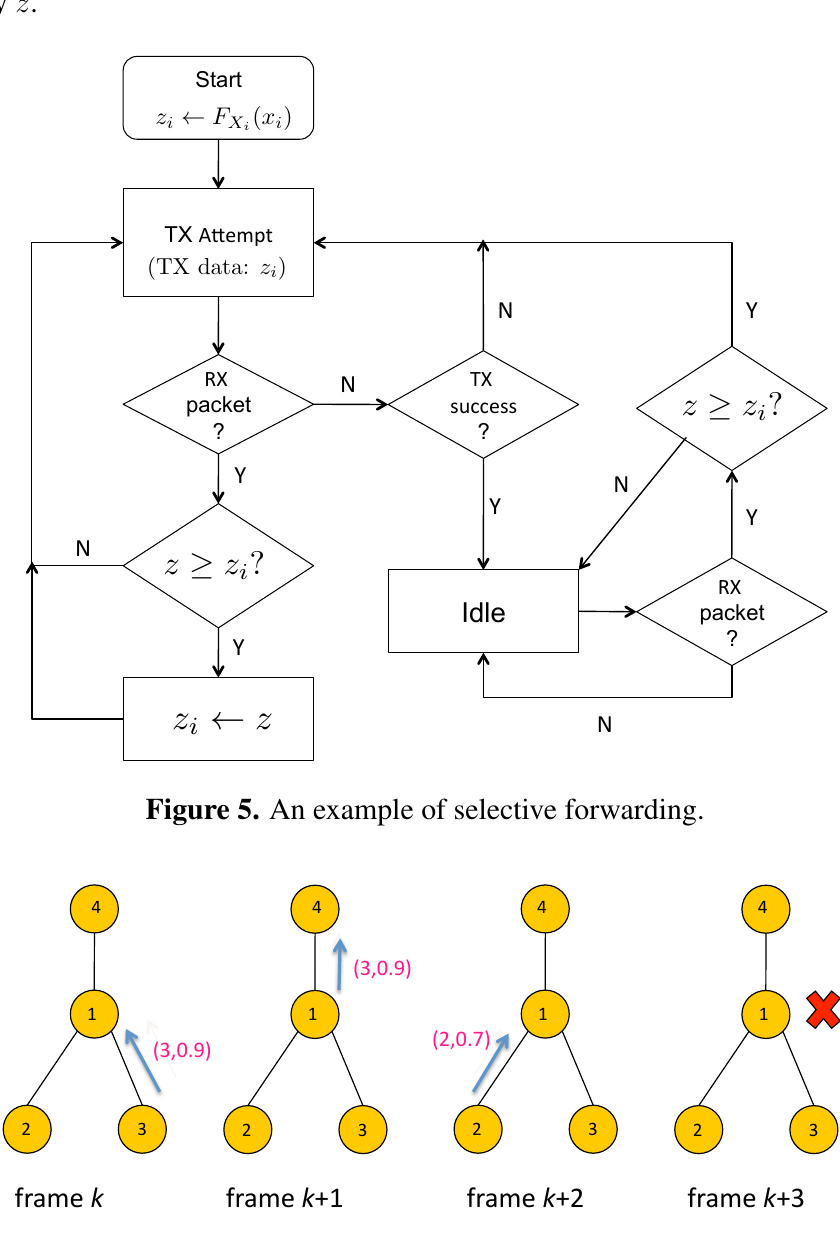
Figure 4. Procedure for selective forwarding. The data (score) of the received packet is denoted by z .